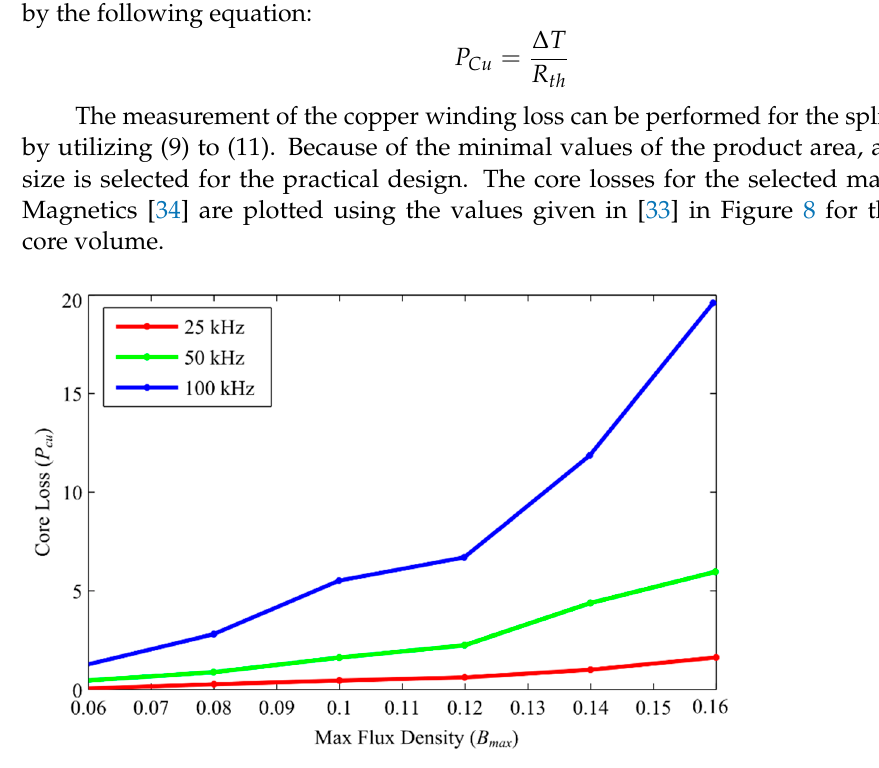
Figure 8. Core loss induced by the inductors under different switching frequencies.